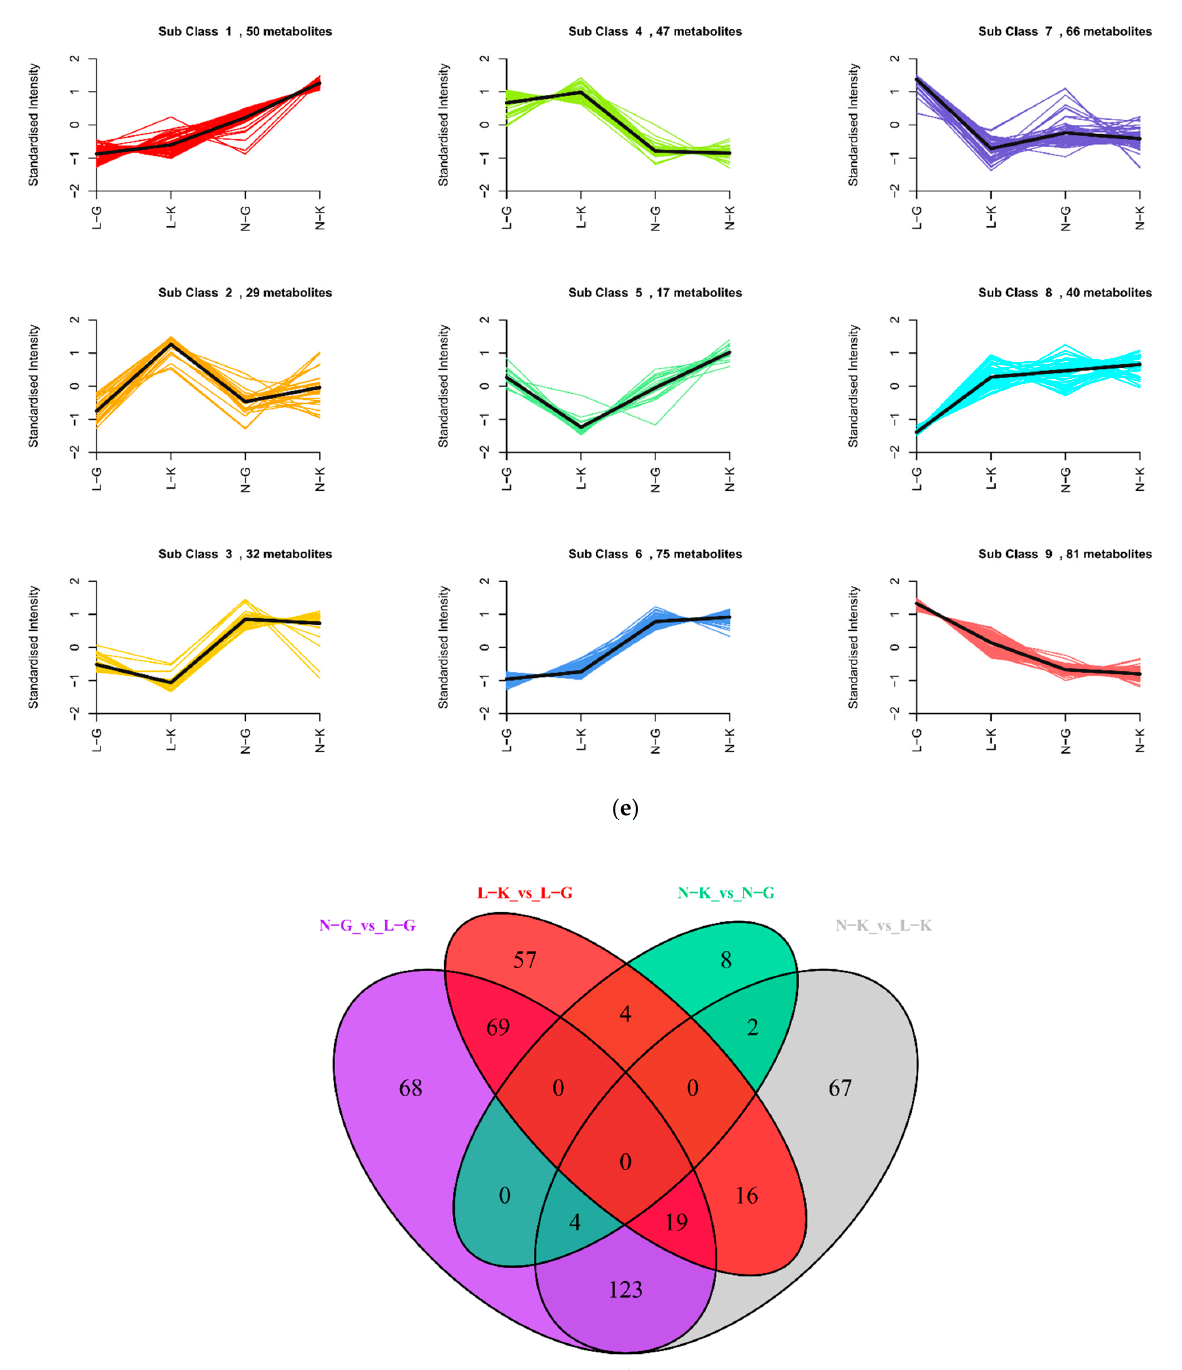
Figure 2. Differential metabolite volcano maps: ( a ) L-K vs. L-G, ( b ) N-G vs. L-G, ( c ) N-K vs. L-K, and ( d ) N-K vs. N-G. Each point in the volcano map represents a metabolite, in which the green points represent downregulated differential metabolites, the red points represent upregulated differential metabolites, and the gray points represent the detected but insignificant metabolites. The abscissa represents the logarithm (log2FC) of the quantitative difference multiples of a metabolite in two samples. The greater the absolute value of the abscissa the greater the differential expression. ( e ) Differental metabolite K-means diagram, ( f ) Venn diagram, wherein each circle represents a comparison group. The number of circles and overlapping parts represents the number of common differential metabolites between the comparison groups and the number without overlapping parts represents the number of unique differential metabolites in the comparison